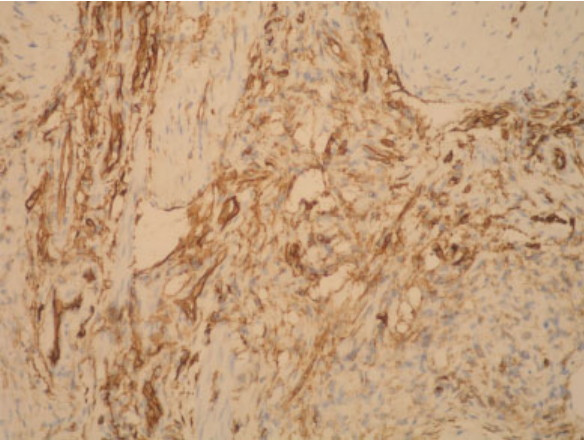
Fig. 6 Immunohistochemistry increased (cid:3) 20; CD34 positive cells inside hyaline stroma.